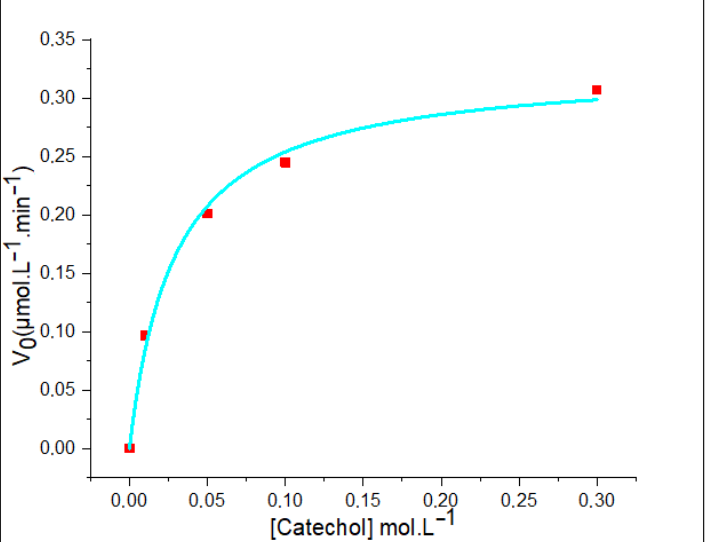
Figure 6. Correlation between reaction rate and catechol concentrations catalyzed by [(Cl) 2 Mn(RCOOET)].